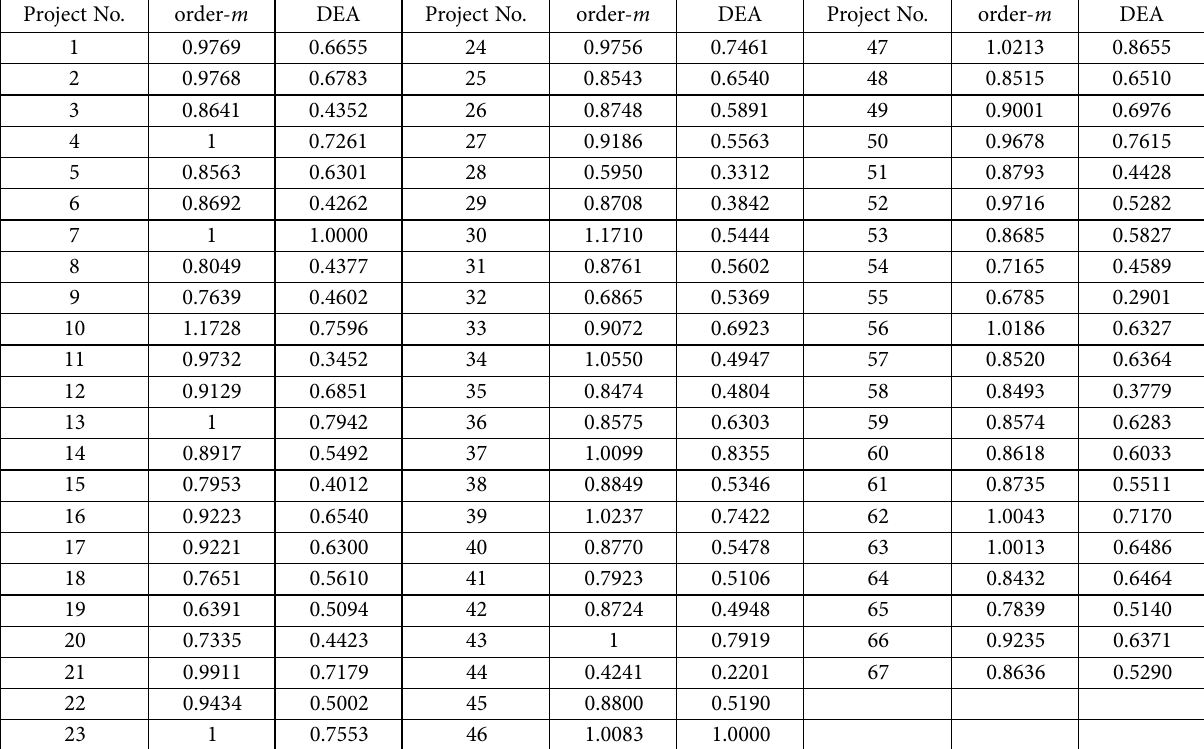
Table 6. Input-oriented efficiency values of production frontier